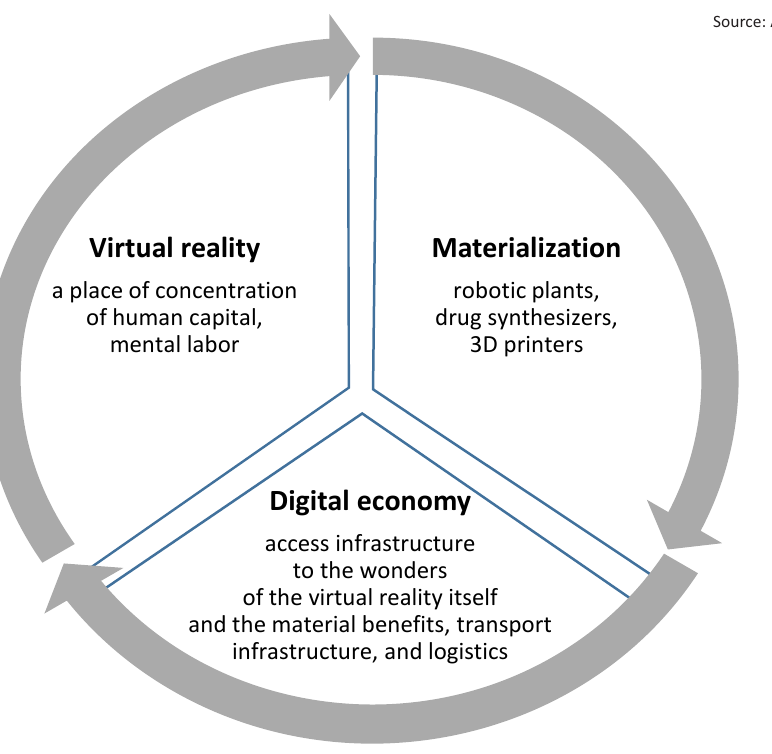
Figure 2. Forming sectors of the “new economy” inside the sixth technological order